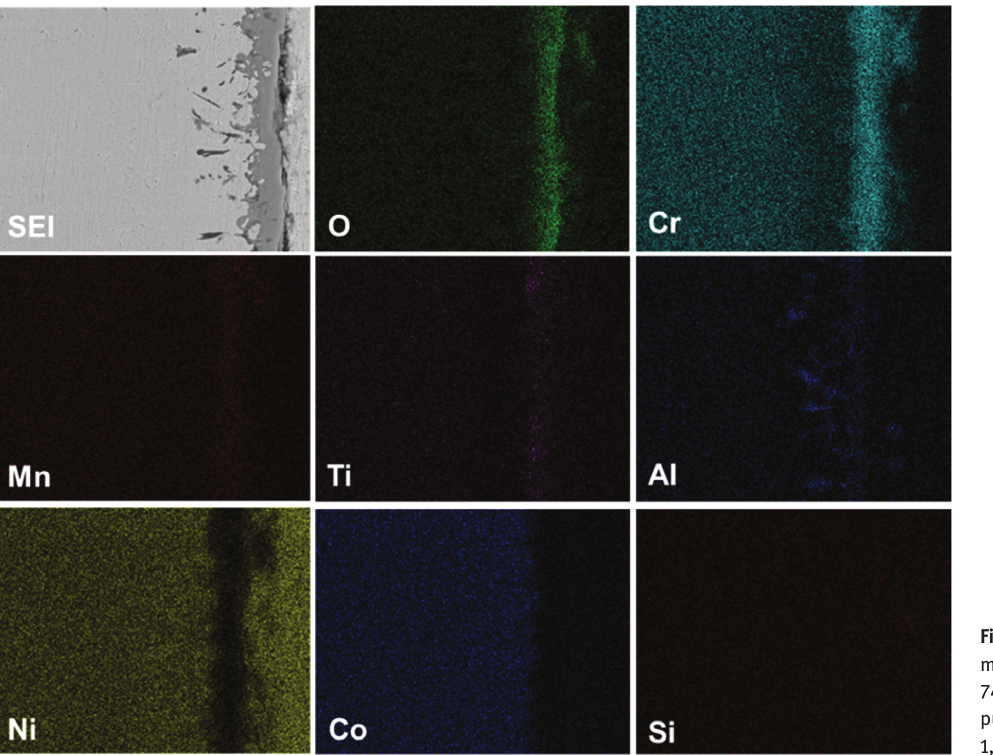
Figure 7: Element mapping of Inconel 740H after oxidation in pure steam at 750°C for 1,000